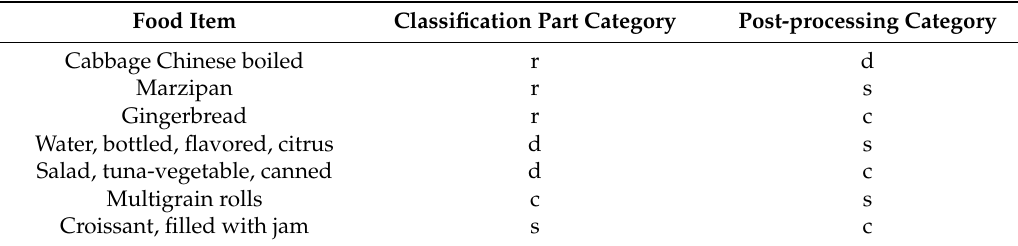
Table 6. Food categories for seven food items after post-processing rules. Classification part category is the food category assigned by the StandFood classification part. Post-processing category is the category assigned after post-processing